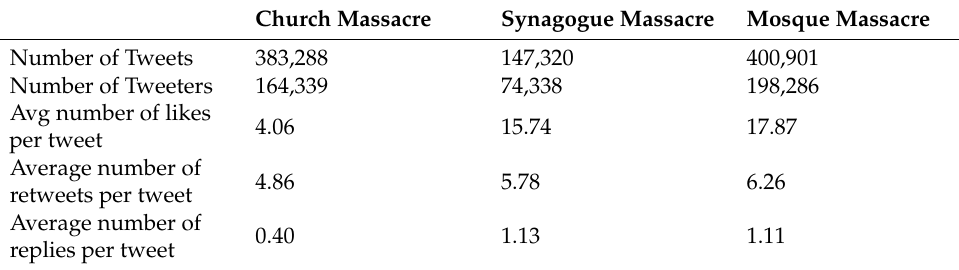
Table 2. Tweet statistics for the three